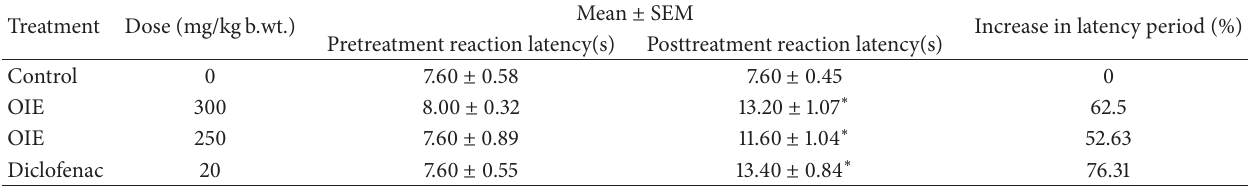
Table 1: Effect of Oroxylum indicum on the analgesic activity in mice by hot plate test. Treatment Dose (mg/kgb.wt.)